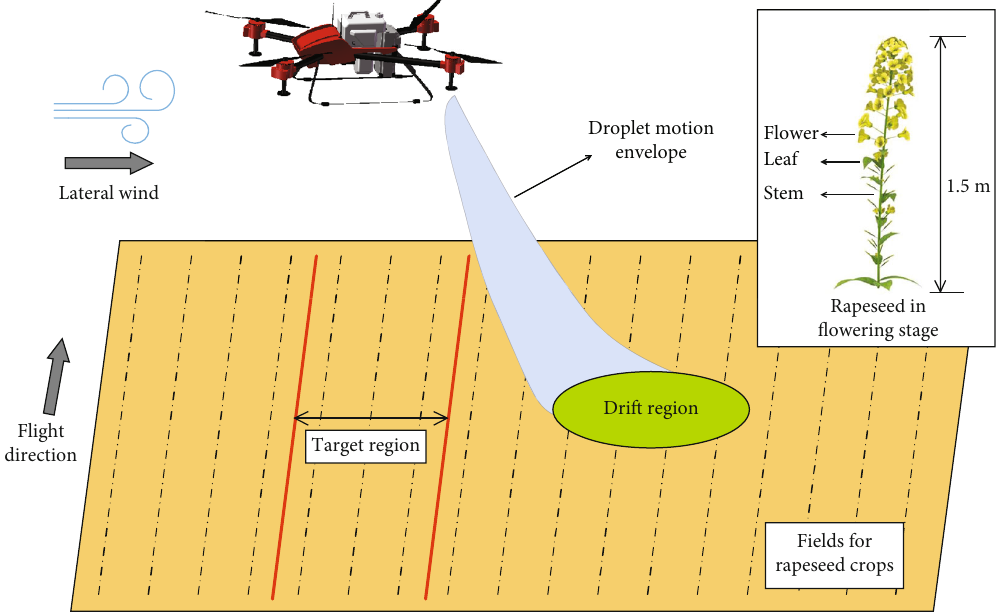
Figure 1: The schematic diagram of oilseed rape aerial